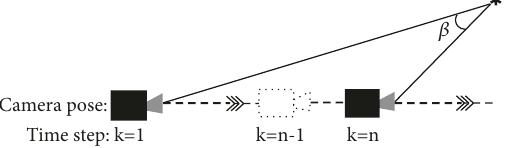
Figure 6: Parallax